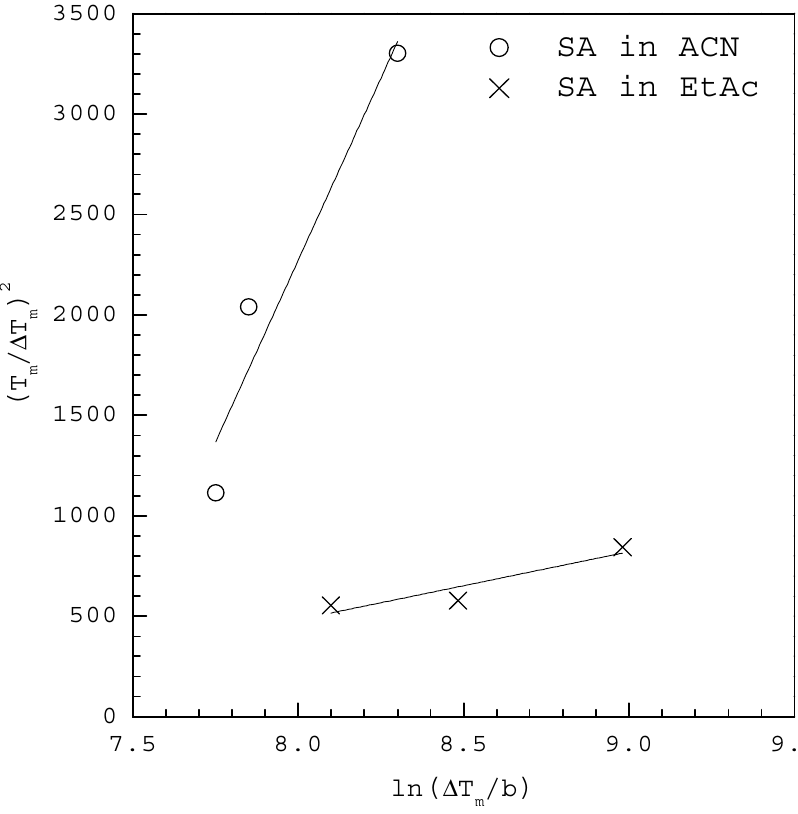
Table 1. Comparison of γ and A (cid:2894) obtained from the MSZW and induction time data for some crys- tallization systems.